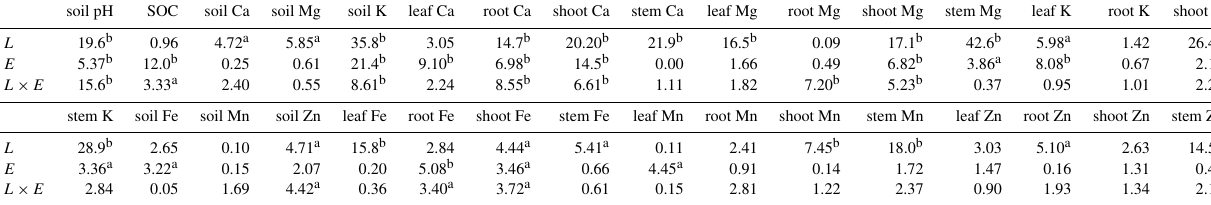
Table 1. Effects ( F values) of plant type ( L , tree or shrub), elevation position ( E ), and their interactions on soil pH, soil organic carbon (SOC), base cations and micronutrients in soils (exchangeable/available form), and plants (total) across sampling sites. soil pH SOC soil Ca soil Mg soil K leaf Ca root Ca shoot Ca stem Ca leaf Mg root Mg shoot Mg stem Mg leaf K root K shoot K